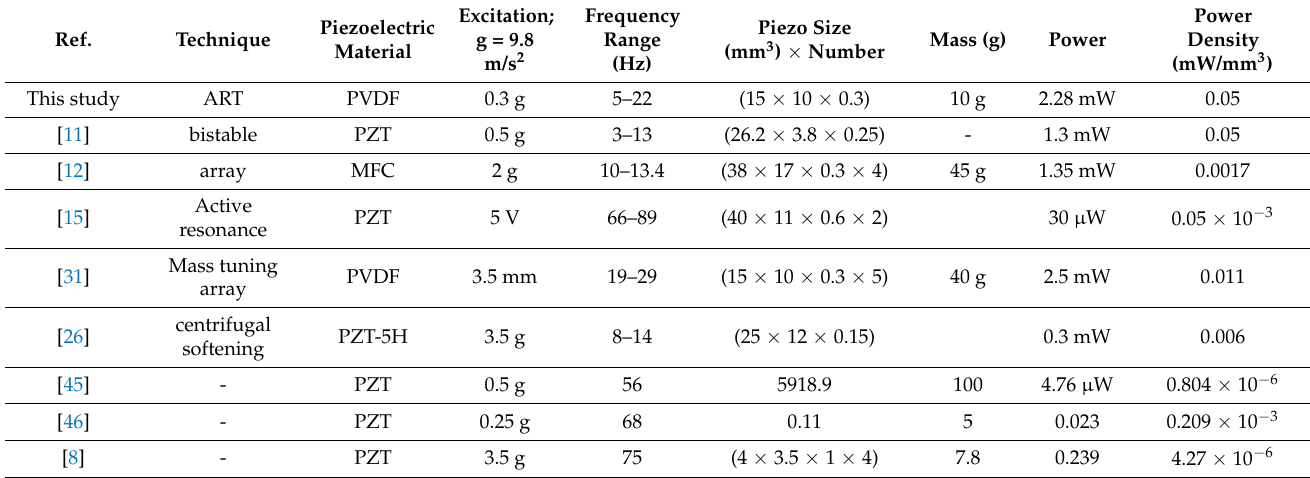
Table 7. Performance Comparison of the proposed techniques with related techniques.